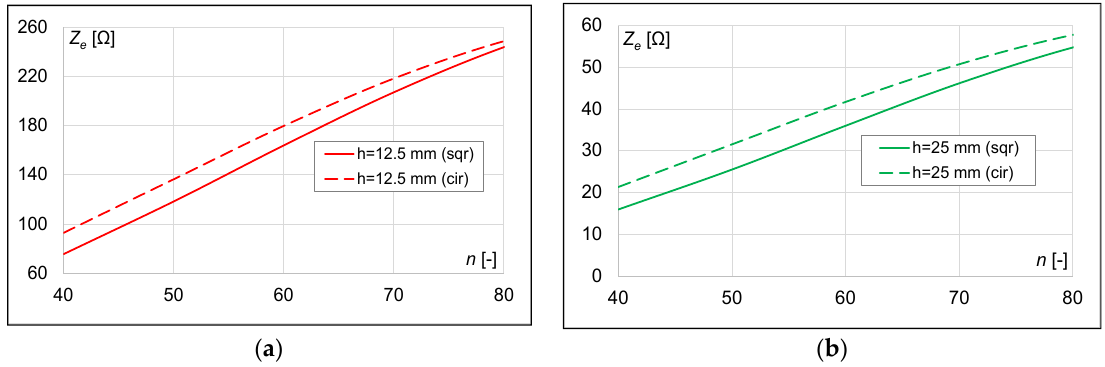
Figure 7. Load impedance at f max for obtaining a maximum efficiency for coil with r = 25 mm at the following distances: ( a ) h = 0.5 r ; ( b ) h = r .